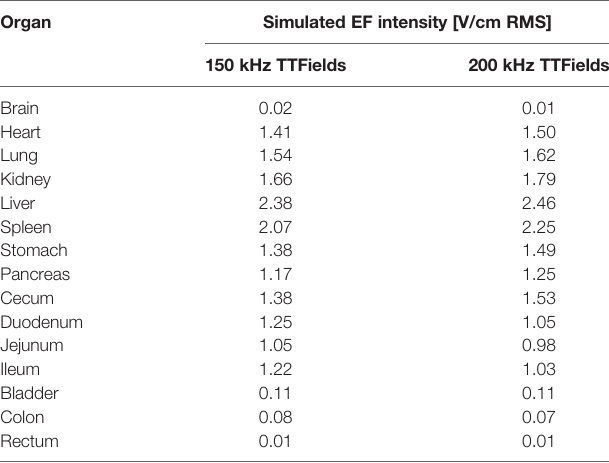
Currents were selected for each frequency based on the results of Table 1